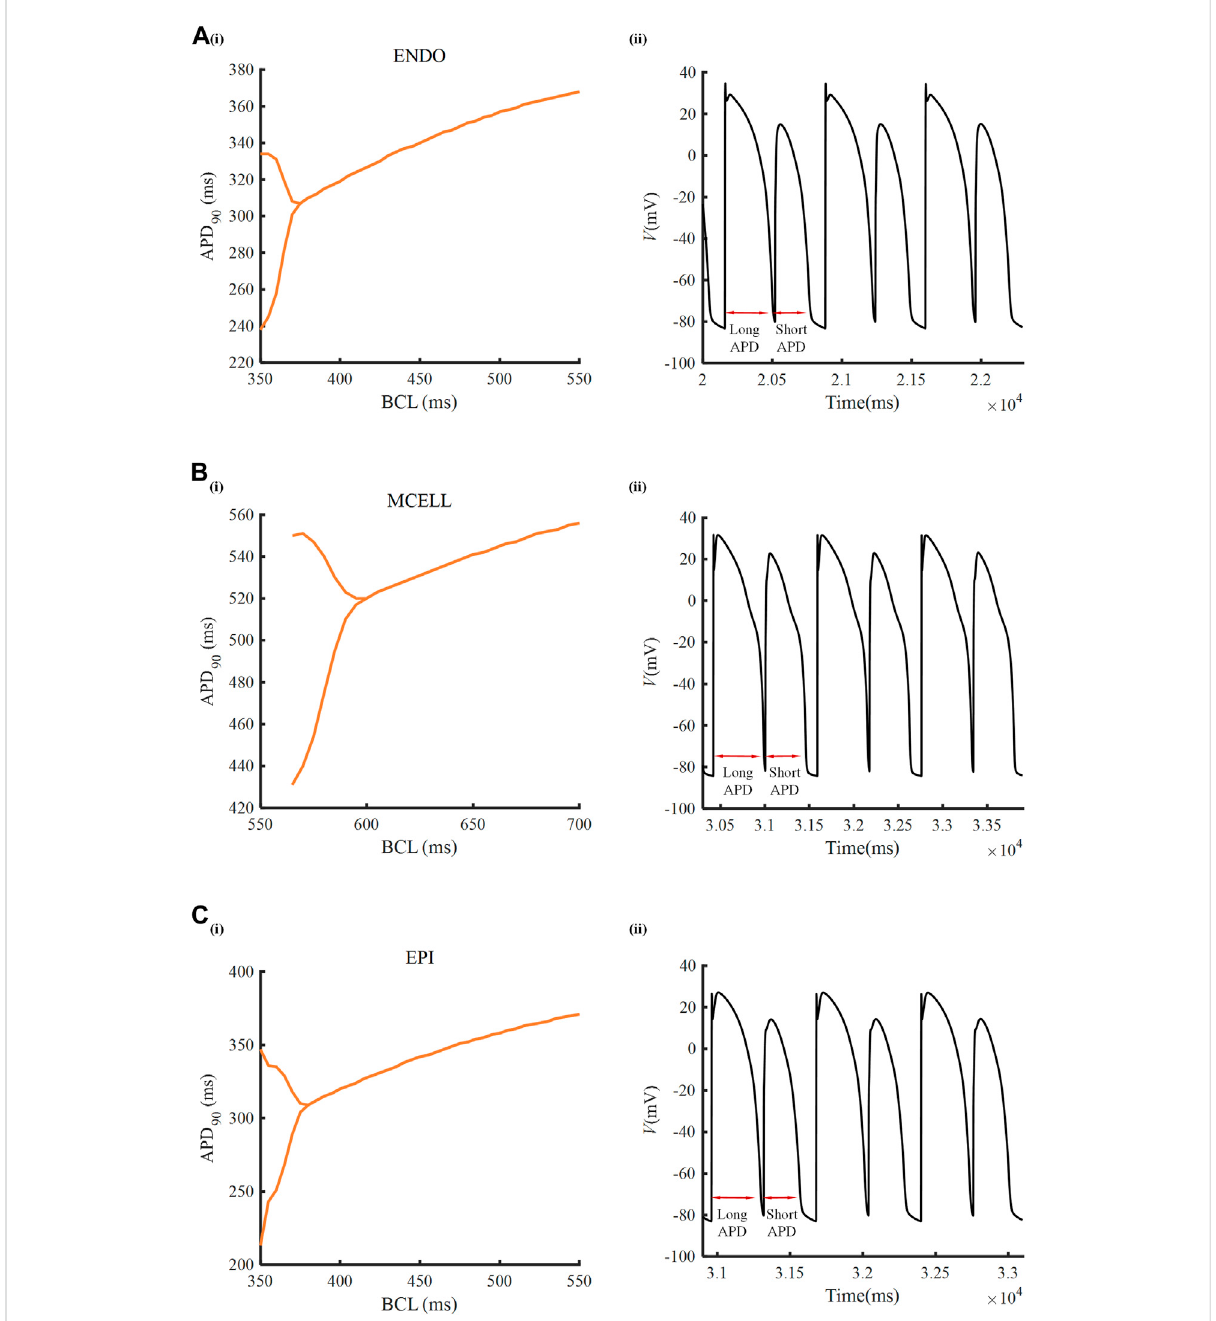
FIGURE 4 Alternans induced by ATO. [A(i) – C(i)] APD 90 rate-dependent curves of endocardial cells (ENDO), middle cells (MCELL) and epicardial cells (EPI) incubated with 3 μ M ATO. [A(ii) – C(ii)] The representative membrane potentials of Figure [A(i) – C(i)] with the basic cycle lengths at 360, 585, and 360 ms,